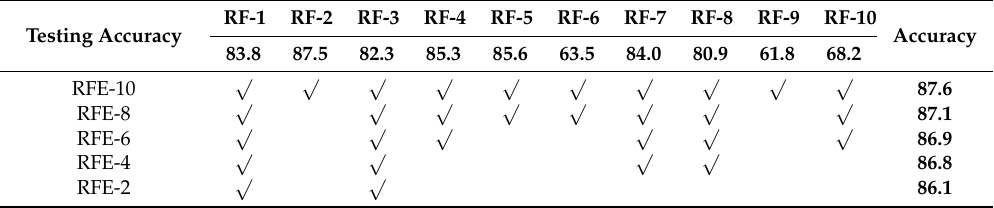
Table 3. Overall accuracies of the RF ensemble (RFE) with different numbers of RF classifiers.